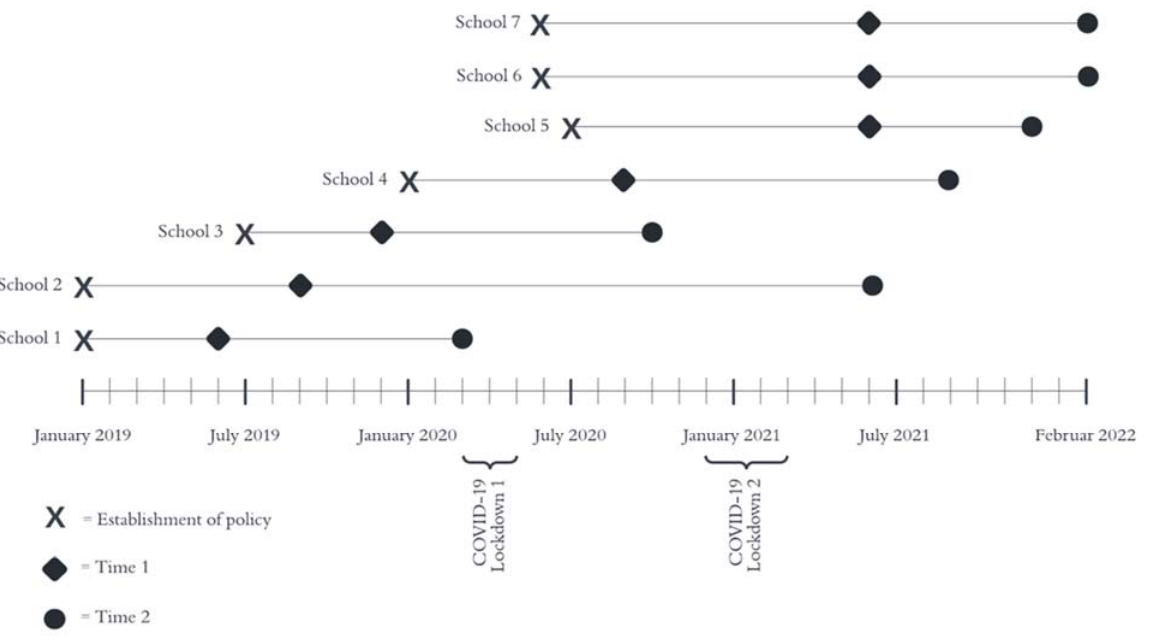
Figure 1. Data collection at Time 1 and Time 2 after the establishment of the smoke-free school hours policy.